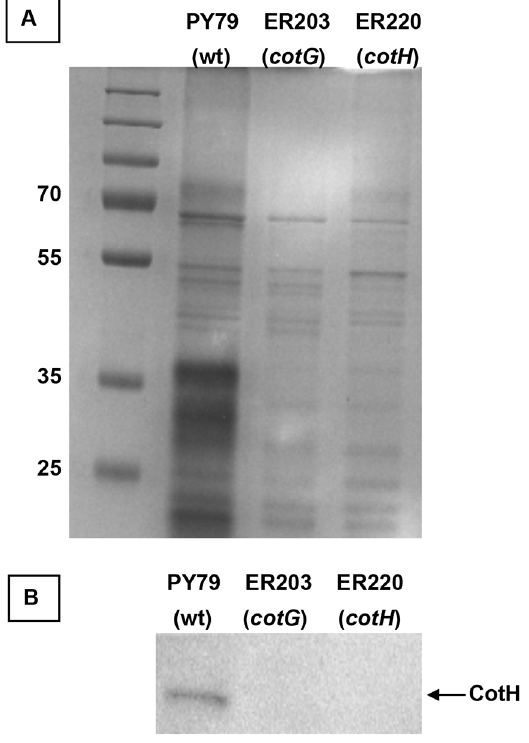
Figure 1. Production of CotH in a cotG null mutant. (A) SDS-PAGE fractionation of coat proteins from a wild type strain (PY79) and isogenic strains carrying null mutations in cotG (ER203) or in cotH (ER220). A molecular weight marker is also present and the size of relevant bands indicated. (B) Western blot with anti-CotH antibody of the same three strains analyzed in panel A. The arrow points to the CotH specific band.